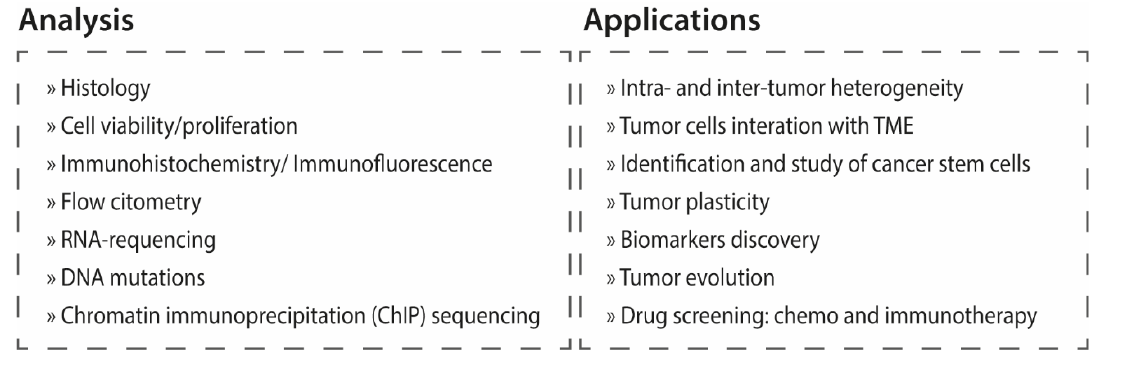
Figure 3. Summary of the main analysis used to characterize the organoids and compare with the primary tumors, and main applications of the models.